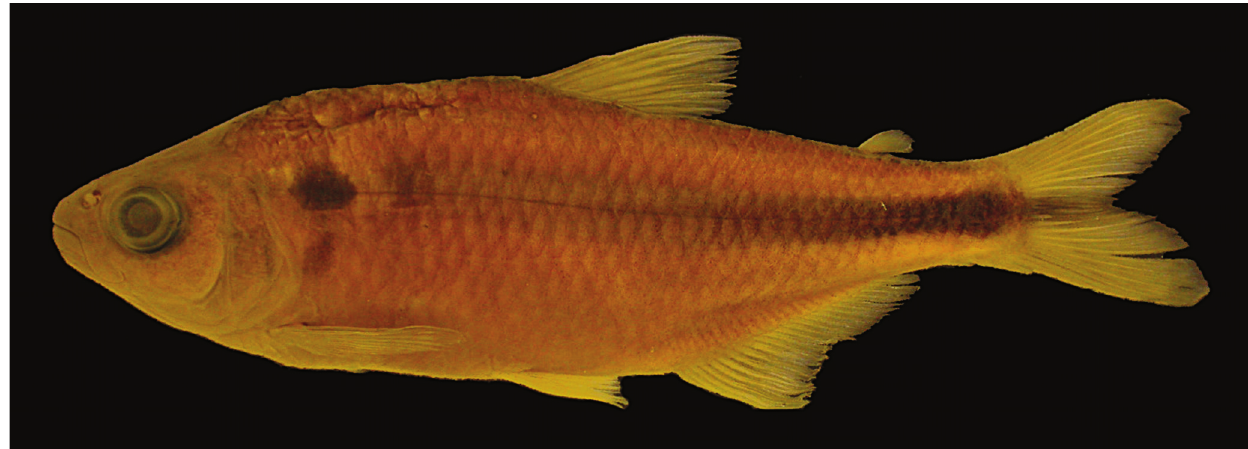
Fig. 7. Astyanax xiru , new species, MCP 19986, 95.7 mm SL, holotype, rio Feitoria, rio Jacuí drainage, Sapiranga, Rio Grande do Sul,